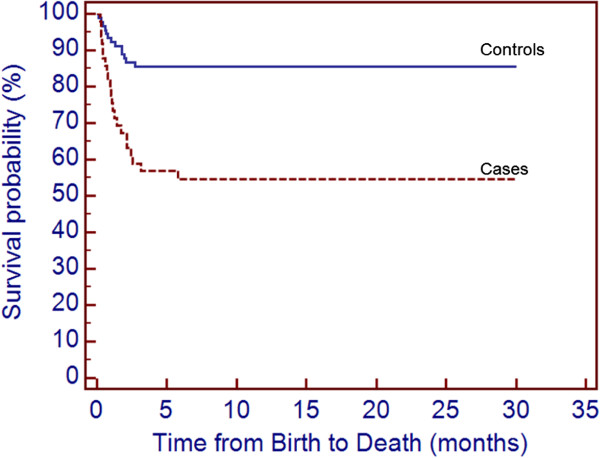
Survival of very low birth weight preterm infants with IC (followed to 18–24 months corrected age) is significantly less than controls (log-rank test: chi-square 16.46; df =1; HR = 3.74 (95% CI: 1.83- 7.64); p = 0.0001). Time axis represents chronological age and not corrected age.